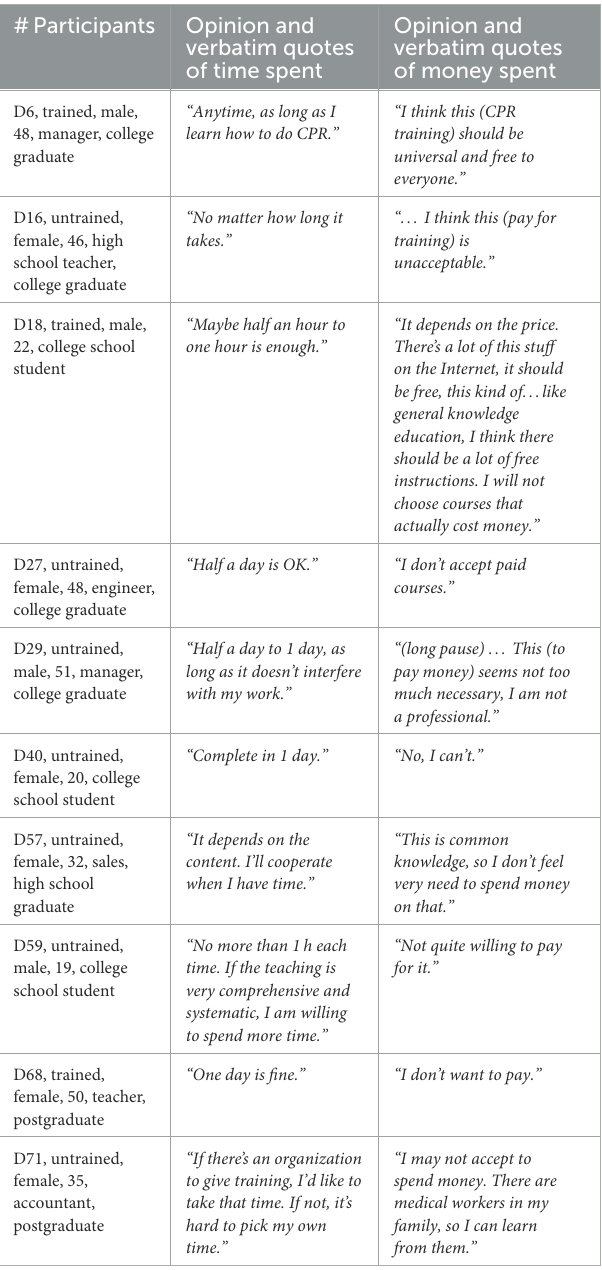
TABLE 2 Demand-side respondents’ varied views on the time and money spent on CPR